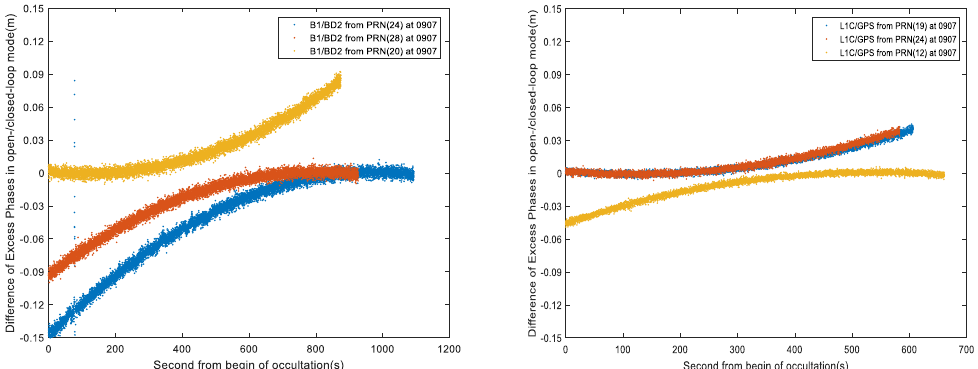
Figure 8. Figure 8. Difference of excess phase retrieved from observations of B1/BD and L1C/GPS in OL/closed- OL / closed-loop tracking mode. Left panel, B1 / BD; Right panel, L1C / loop tracking mode. Left panel, B1/BD; Right panel, L1C/GPS.